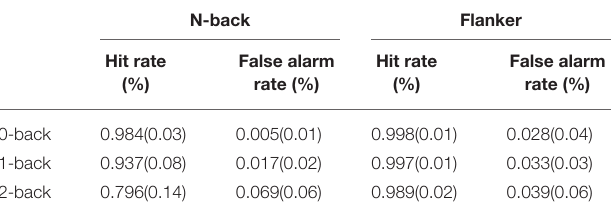
TABLE 2 | Mean value and standard deviation of hit and false alarm (FA) rates. N-back Flanker